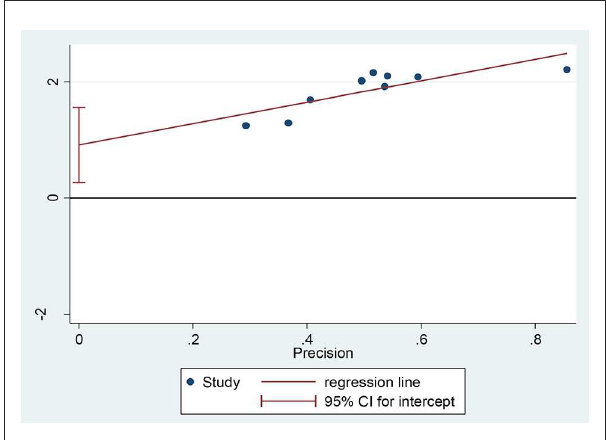
FIGURE11 Regression graph of favorable attitude toward epilepsy.